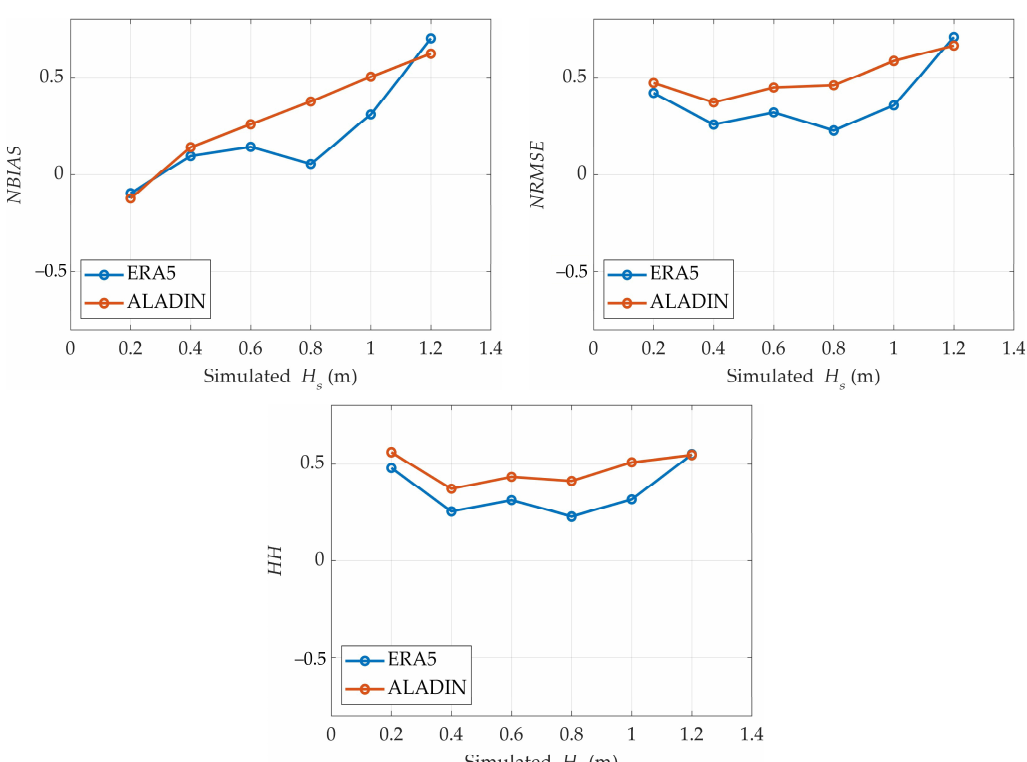
Figure 13. Plots showing the relationship between the simulated significant wave heights (forced by ERA5 (blue) and ALADIN (orange) reanalysis wind data) and various performance metrics ( HH , NRMSE , NBIAS ) for the validation